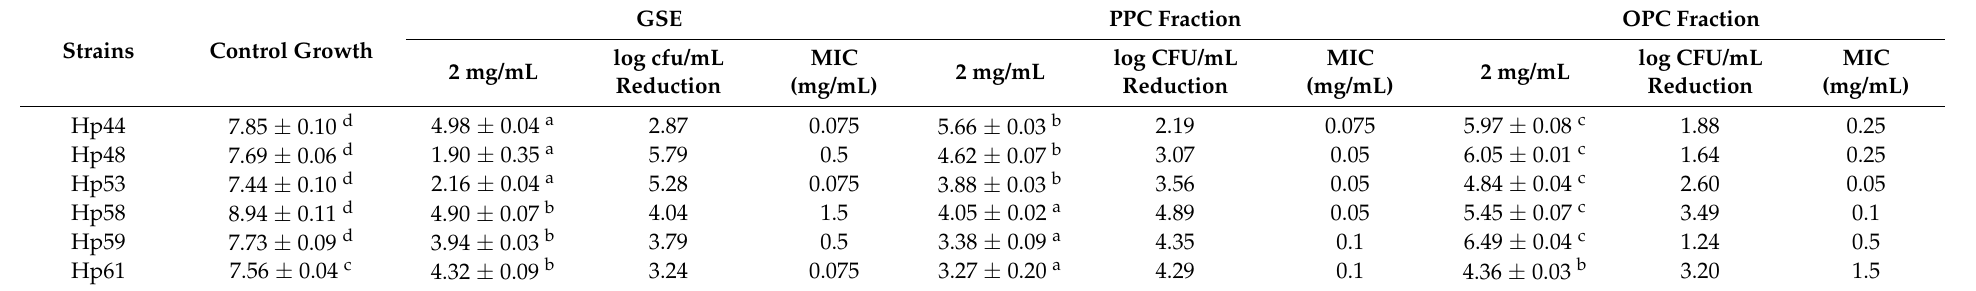
Table 4. Effects of grape seed extract (GSE) and its polymeric procyanidin (PPC), and oligomeric procyanidin (OPC) fractions at 2 mg/mL on the viable counts of different H. pylori strains. Results of bacterial growth are expressed as log CFU/mL ± SD ( n =